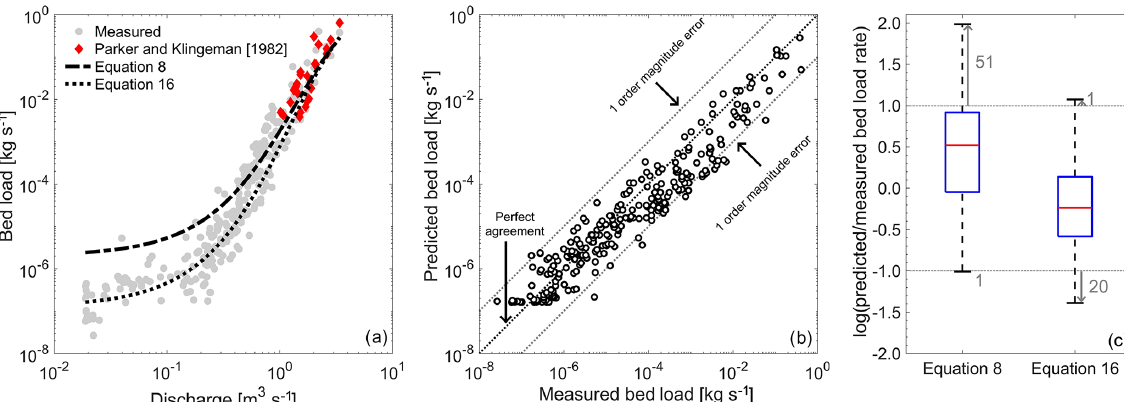
Figure 10. (a) Measured and predicted bed load transport rates as a function of discharge. Equations (8) and (16) can be represented as a continuous line because the spatial distributions of τ and the α and β parameters vary with Q . Predictions of Parker and Klingeman (1982) were calculated using the reach-averaged shear stress based on Milhous (1973) measurements. Therefore, shear stress does not monotonically increase with larger discharges. (b) Measured versus predicted bed load transport rate using Eq. (16). (c) The log of the ratio of predicted to measured sediment bed load rate for Eqs. (8) and (16). Grey arrows extending out of the box correspond to the number of events under- or overpredicted bed load by more than an order magnitude